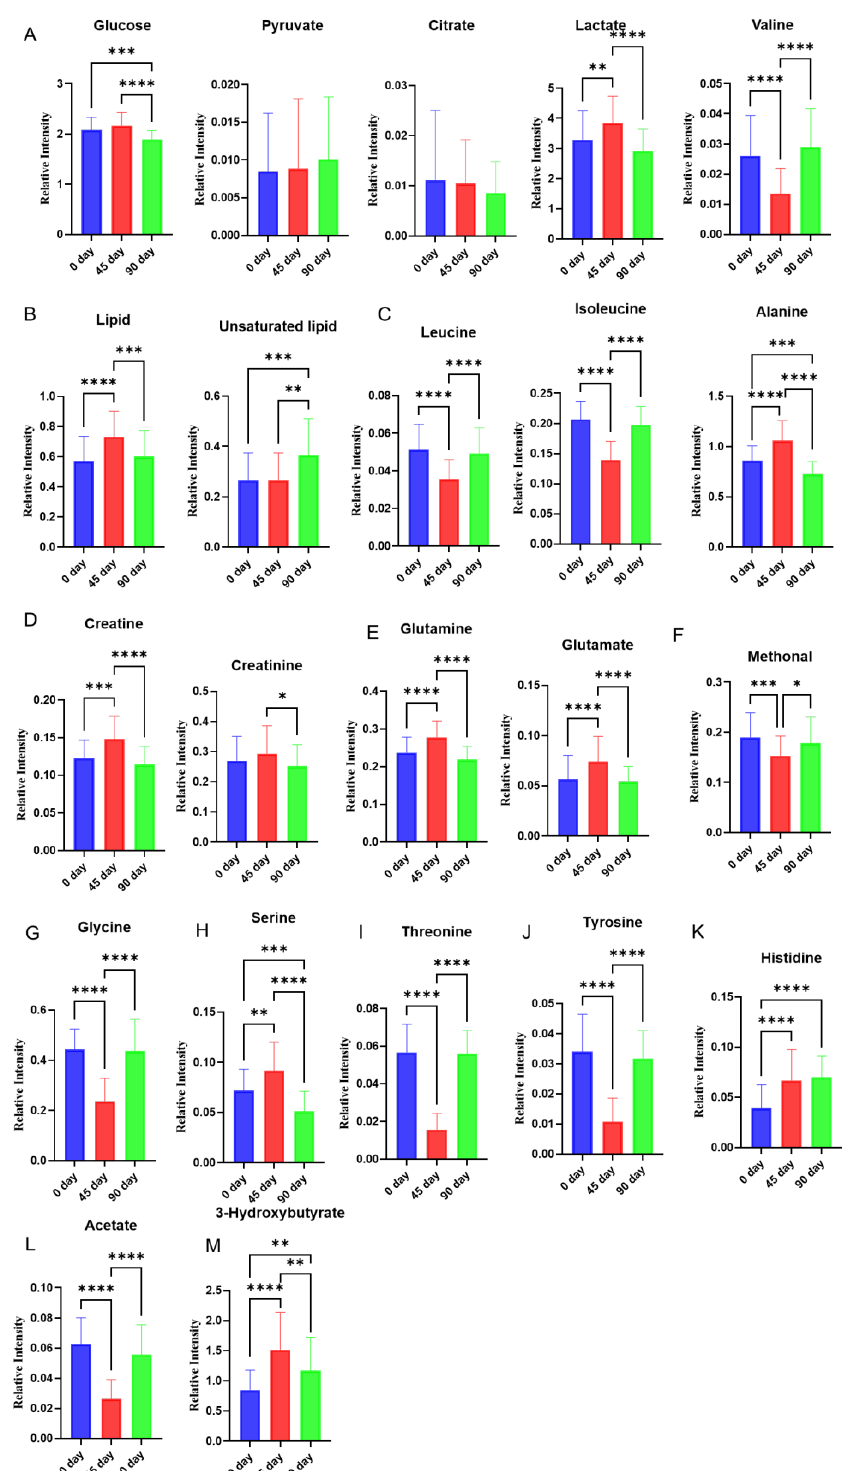
Figure 3. Effect of sea buckthorn puree on plasma metabolites in hypercholesterolemia population. Metabolites involved in glycolysis and TCA cycle (glucose, lactate, alanine, citrate, and pyruvate) ( A ), Lipids ( B ), Branched-chain amino acids (leucine, isoleucine, and valine) ( C ), Creatine and creatinine ( D ), Glutamine and glutamate ( E ), Methanol ( F ), Glycine ( G ), Serine ( H ), Threonine ( I ), tyrosine ( J ), Histidine ( K ), Acetate ( L ), 3-hydroxybutyrate ( M ). n = 44, each group. Note: * p < 0.05, ** p < 0.01, *** p < 0.001, and **** p <